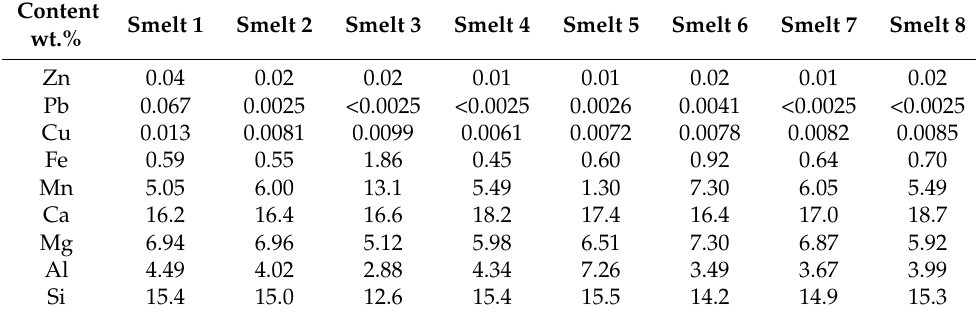
Table 5. Chemical analysis of slag.